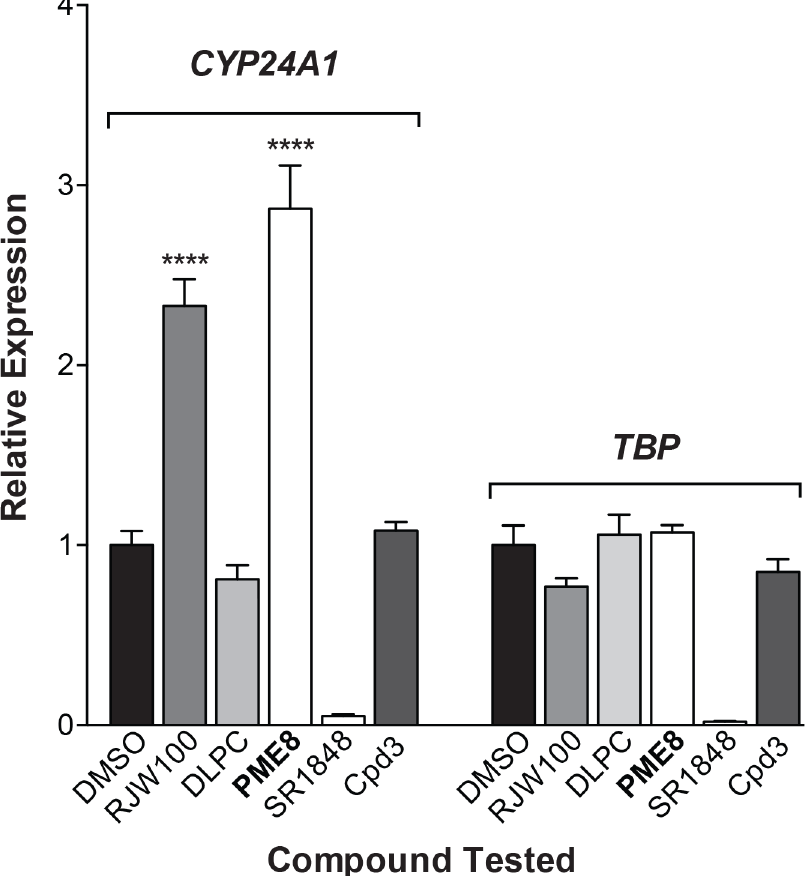
Fig 5. Effects of other published compounds targeting hLRH-1 compared to PME8. All published agonists and antagonists were tested in HepG2-hLRH-1 cells expressing high levels (+Dox) of hLRH-1. Activating compounds were added for 16 h relative to the DMSO control (black bars) at the following concentrations: RJW100 (10 μ M) [7], DLPC (20 μ M) [5], PME8 (10 μ M) (bolded, this study) as well as the two putative antagonist/repressors, SR1848 (10 μ M) [20] and Cpd3 (10 μ M) [21]. Relative levels of the hLRH-1 target, CYP24A1 (left set of bars) and the housekeeping gene, TBP (right set of bars) are shown with all values normalized to GAPDH . Error bars represents SEM and P values = **** <